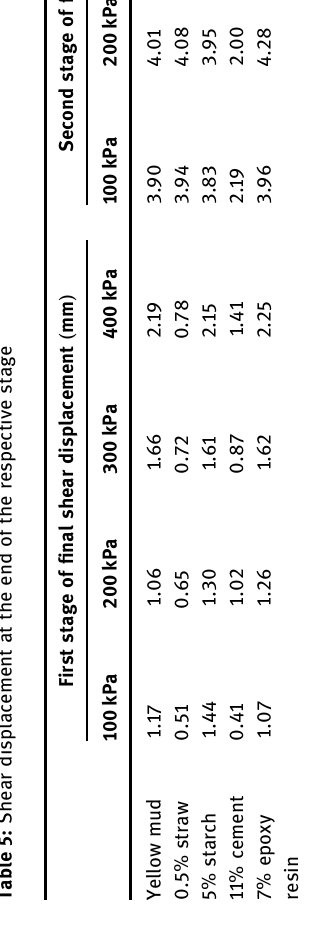
exposed. After the test piece mixed with starch was washed,